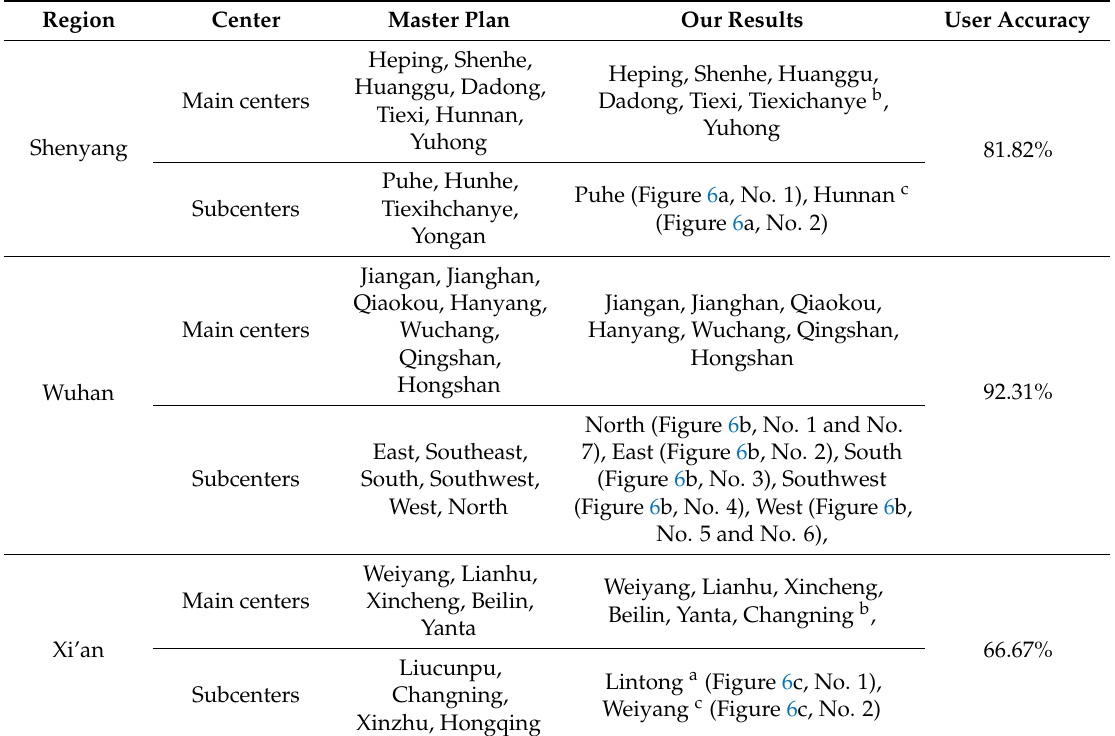
Table 8. Polycentric structure detection